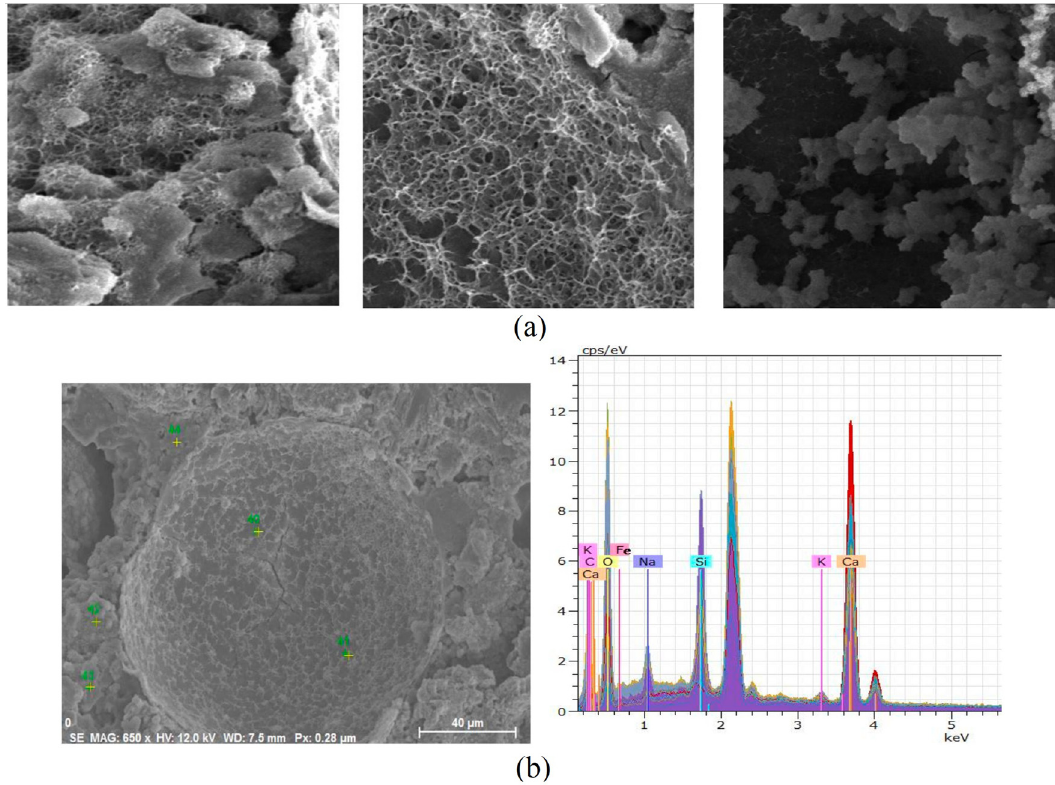
Figure 11: SEM observations of the healed oil well cement pastes containing T1 microcapsules ( a ) various SEM images from the fractured surfaces and ( b ) an SEM image of a microcapsule and the corresponding EDX analysis results of ruptured microcapsules [ 53 ]